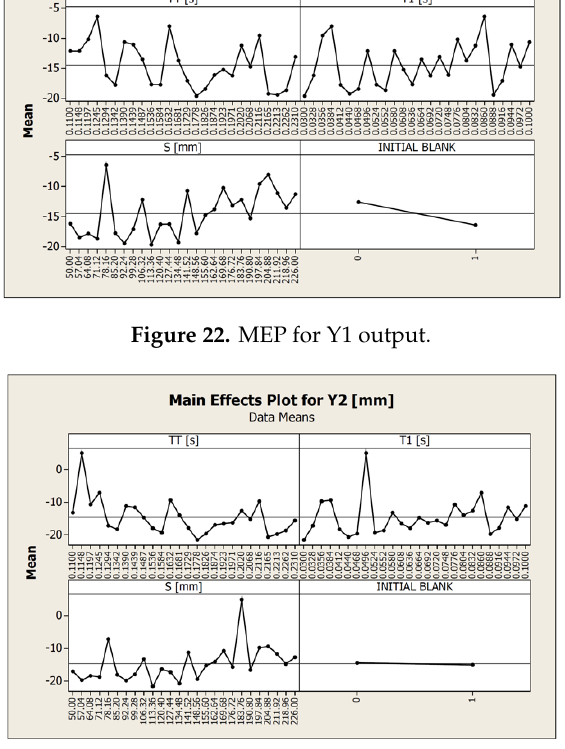
Figure 23. MEP for Y2 output.